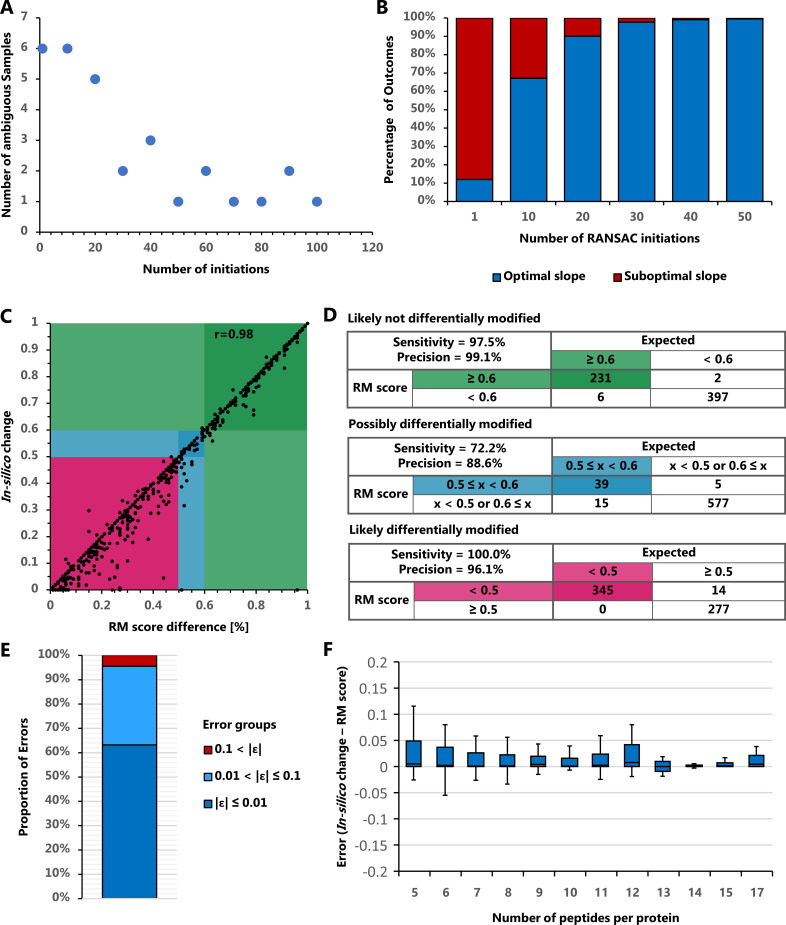
FLEXIQuant-LF reproducibility and error estimation.(A) Number of ambiguous samples with different number of RANSAC initiations. The number of samples with ambiguous results over 1000 runs decreases with increasing number of RANSAC initiations but starts to oscillate between one and two ambiguous samples from 50 initiations upwards. (B) Fraction of optimal and suboptimal outcomes of PMF with sample 30. The frequency of a suboptimal outcome decreases with increasing number of RANSAC initiations. (C) Correlation of the expected/in silico created change with the RM score difference before and after the in silico change. Expected and measured changes highly correlate (Pearson r = 0.98). (D) Classification error estimation using definitions of likely not, possibly, and likely differentially modified as described in Figure 1B. With a sensitivity and precision of 72.2% and 88.6%, respectively, the transition area of possibly differentially modified evaluates expectedly worse than the likely not and likely differentially modified classifications (both with sensitivity and precision >96%). (E) Cumulative quantification error frequencies show 94.7% of cases below 0.1. (F) Quantification error associated with number of peptides used per protein (boxes indicated 2nd and 3rd quartiles while whiskers indicate data 1.5 times the inter quartile range above and below these quartiles). Overall quantification errors are very low and further improve with the number of peptides used for FLEXIQuant-LF analysis.